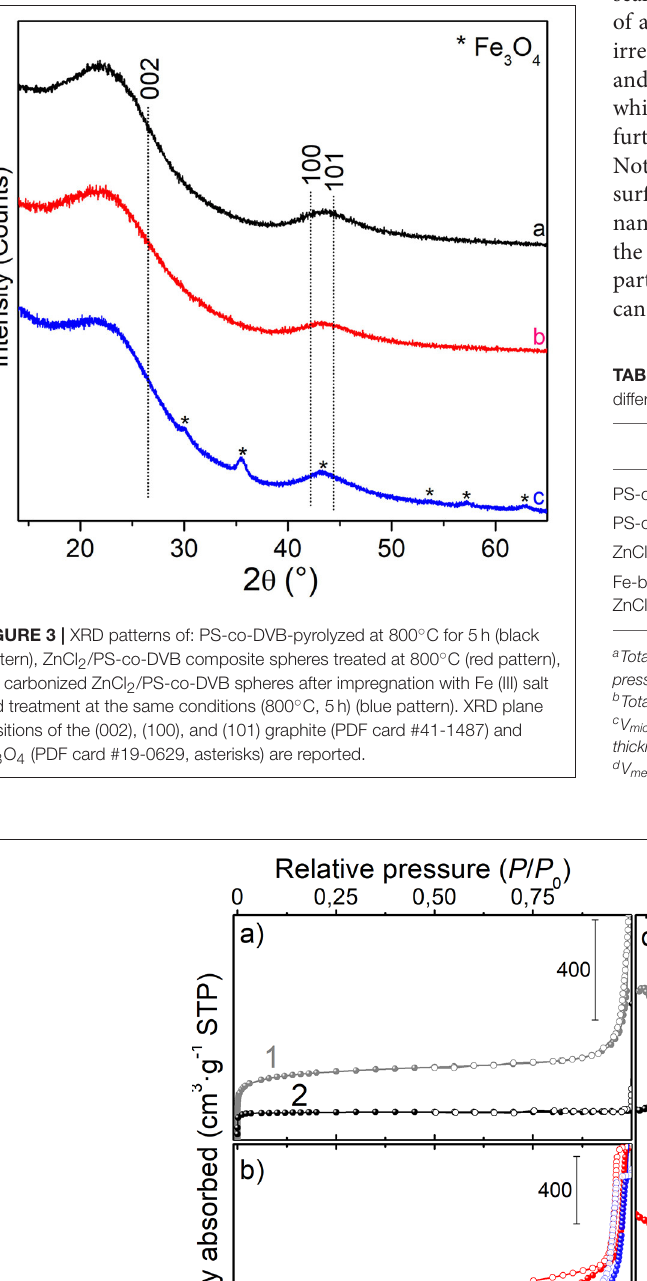
Frontiers in Materials |